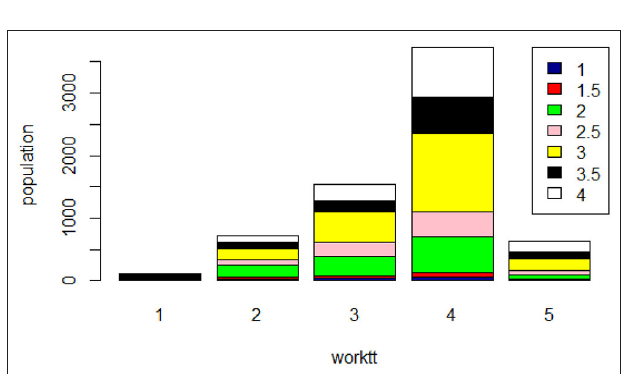
FIGURE 4 | The relationship between mental health and general job satisfaction (worktt is the general job satisfaction; population is the number of employee).